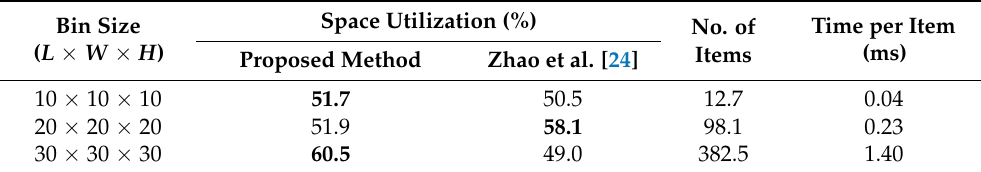
Figure 6. The packing results with different bin sizes: ( a ) bin size of 10 × 10 × 10; ( b ) bin size of 20 × 20 × 20; ( c ) bin size of 30 × 30 × 30. Table 6. The packing results with different bin sizes.